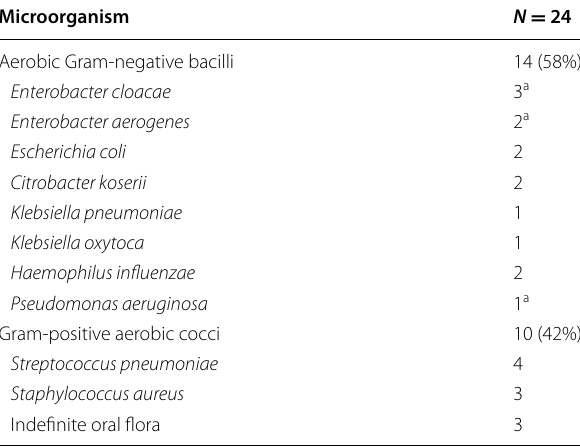
Table 3 Identification of microorganisms isolated from res- piratory samples